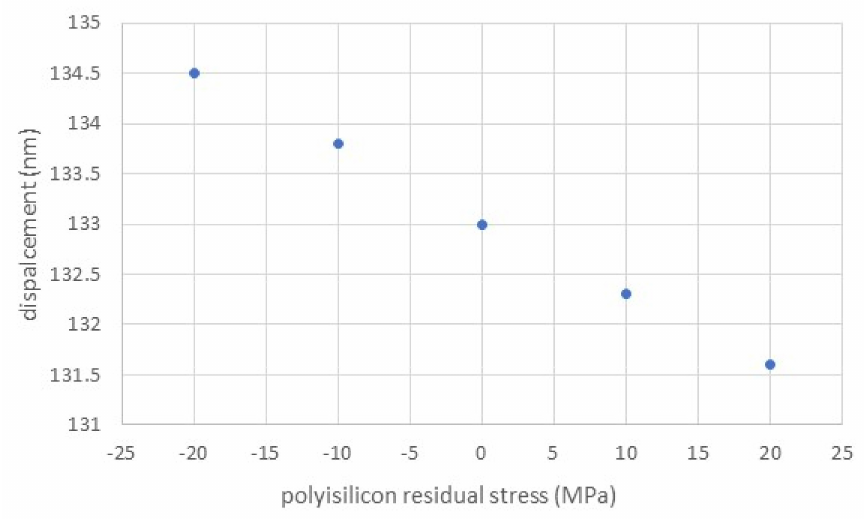
Figure 5. Maximum displacement as a function of polysilicon residual stress with a membrane side of 100 µ m and a polysilicon thickness of 1.5 µ m.